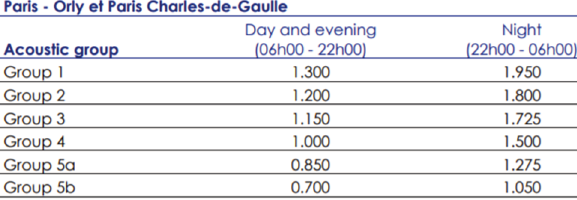
Fig. 6. Acoustic groups and charges for Paris Charles de Gaulle airport